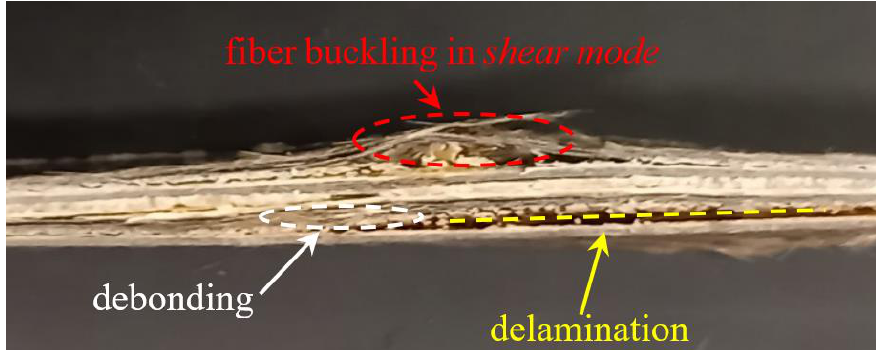
Figure 15. Typical damage of the B-SFRP specimen failure after compressive test.